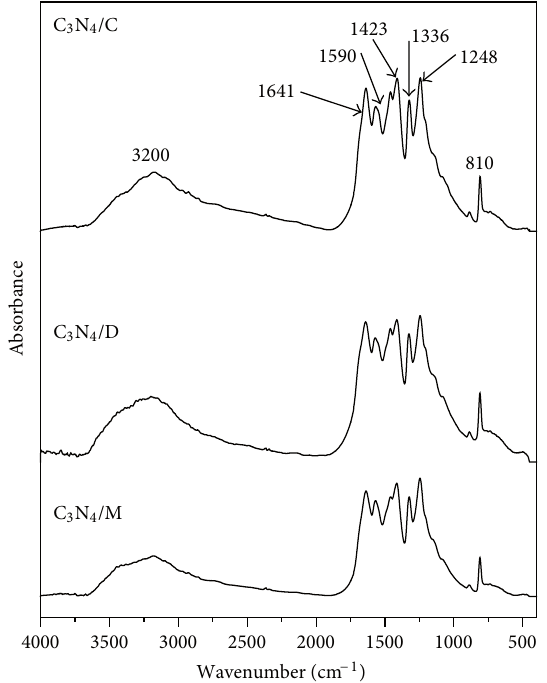
F 2: FT-IR spectra for g-C